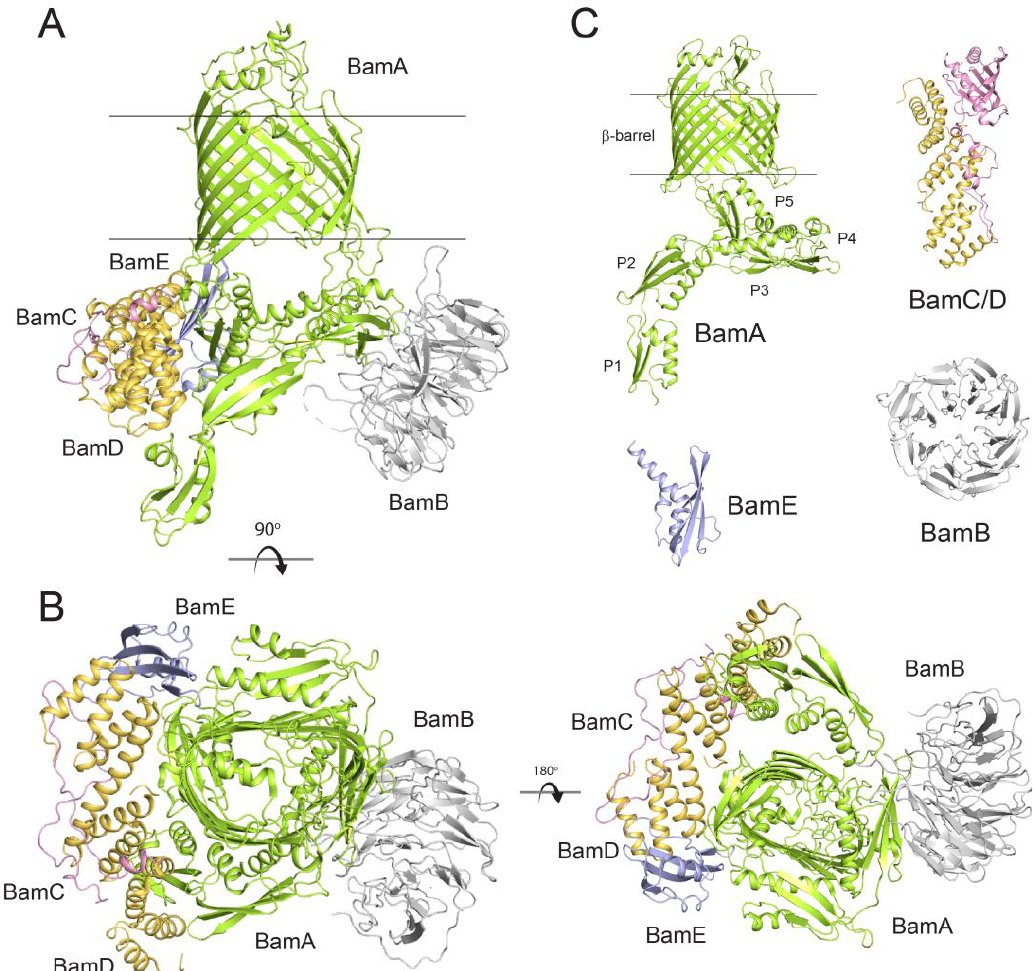
Figure 2. Structures of BAM and the individual Bam proteins from E. coli . ( A ) The structure of fully assembled BAM (PDB ID: 5D0O) shown from the side, transmembrane view; membrane boundaries are indicated by the black lines. ( B ) Orthogonal views of BAM showing the extracellular, top view ( left ) and the periplasmic, bottom view ( right ). ( C ) The individual components BamA from N. gonorrhoeae (PDB ID: 4K3B) showing the β -barrel domain and the POTRA domains (P1-P5), BamB from E. coli (PDB ID: 3Q7N), the BamC/D complex from E. coli (PDB ID: 3TGO), and BamE from N. gonorrhoeae (PDB ID: